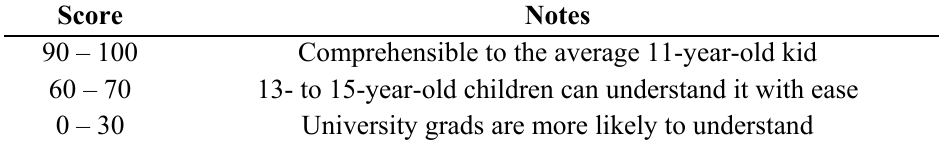
Table 1. Flesch-Kincaid Grade Level Categories [10]